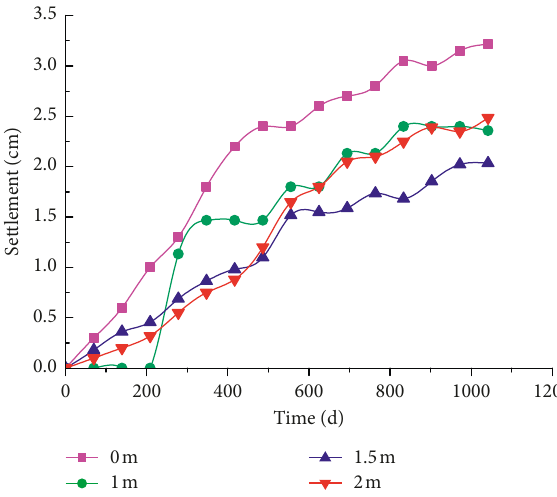
Figure 11: Settlement curve after completion of